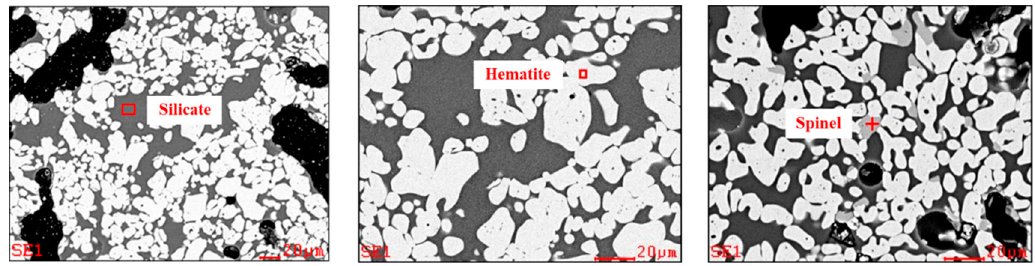
Figure 4. SEM images of the deposit in rotary kiln [26] .